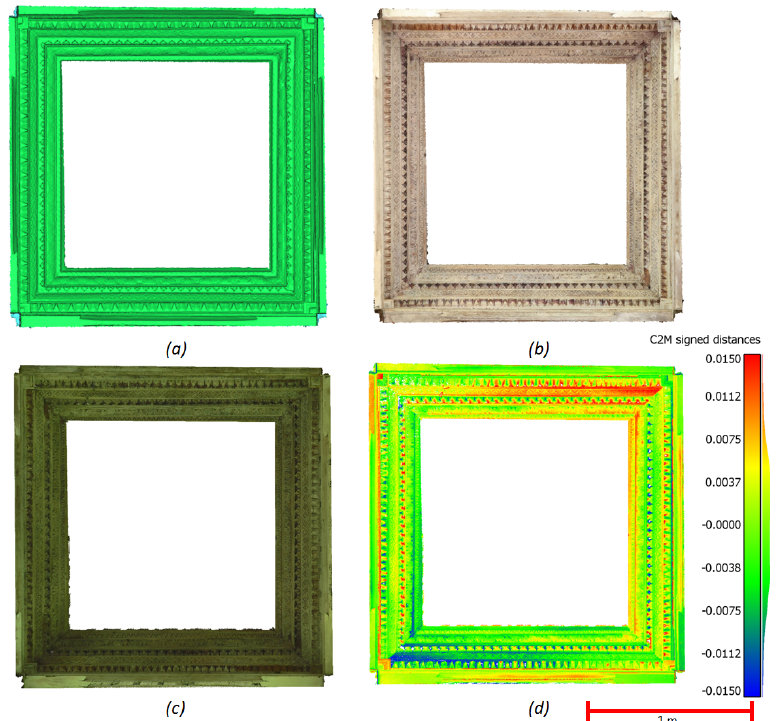
Figure 9. Results for the woodwork on the Central Pavilion’s ceilings; the 3D mesh ( a ) and textured ( b ) models used as a reference against TLS point cloud ( c ). The cloud-to-mesh analysis ( d ) yielded a mean error of 0.4 mm with a standard deviation of 5.6